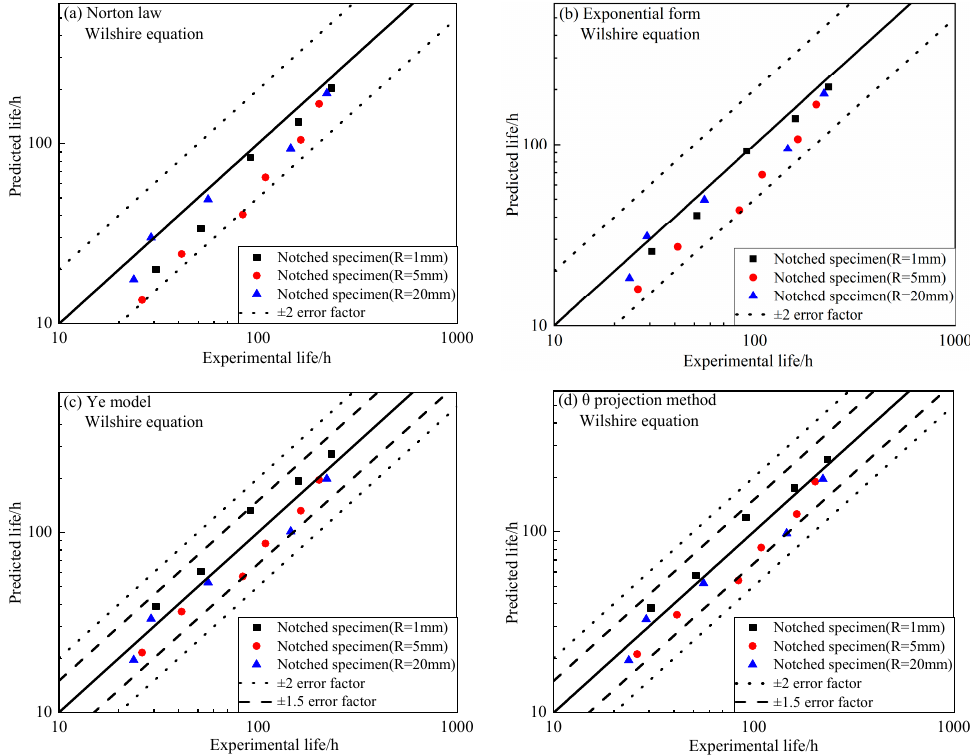
Figure 12. The prediction results are based on different constitutive models and the Wilshire equation: ( a ) Norton law; ( b ) Exponential form; ( c ) Ye model; ( d ) θ projection method.